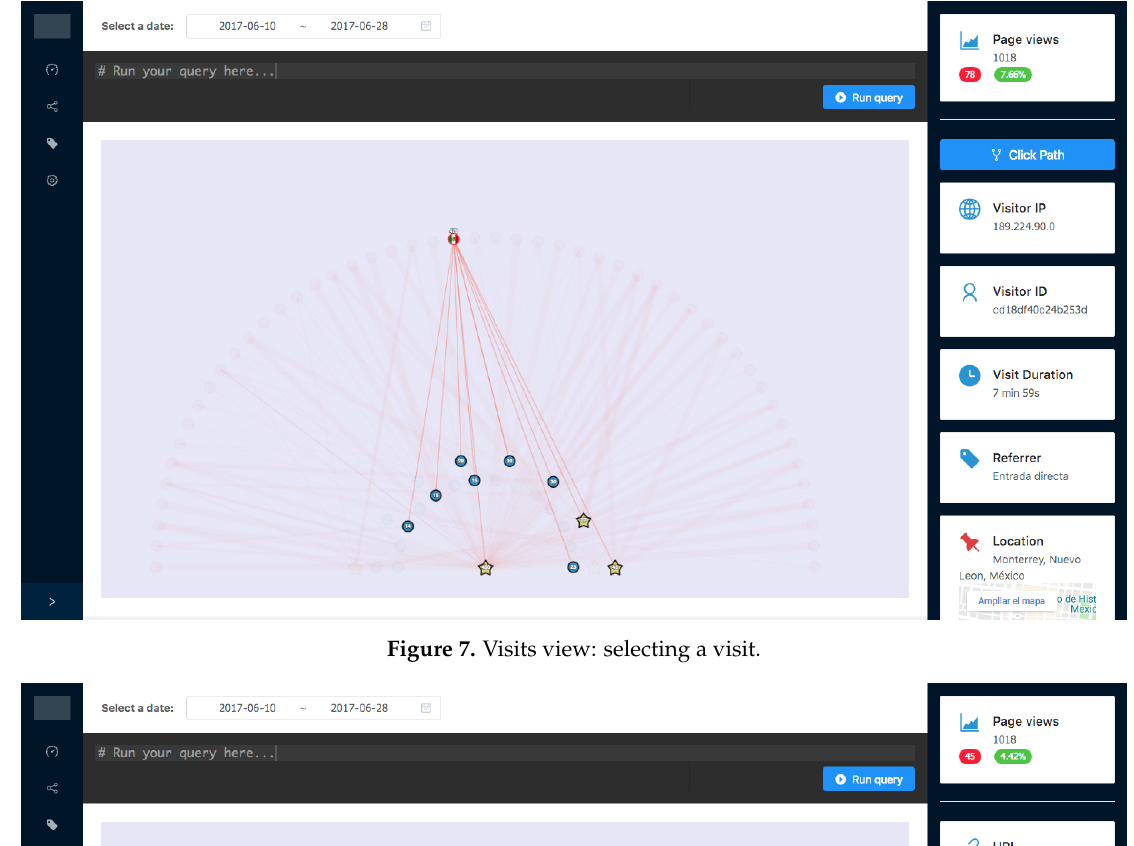
Figure 7. Visits view: selecting a visit.